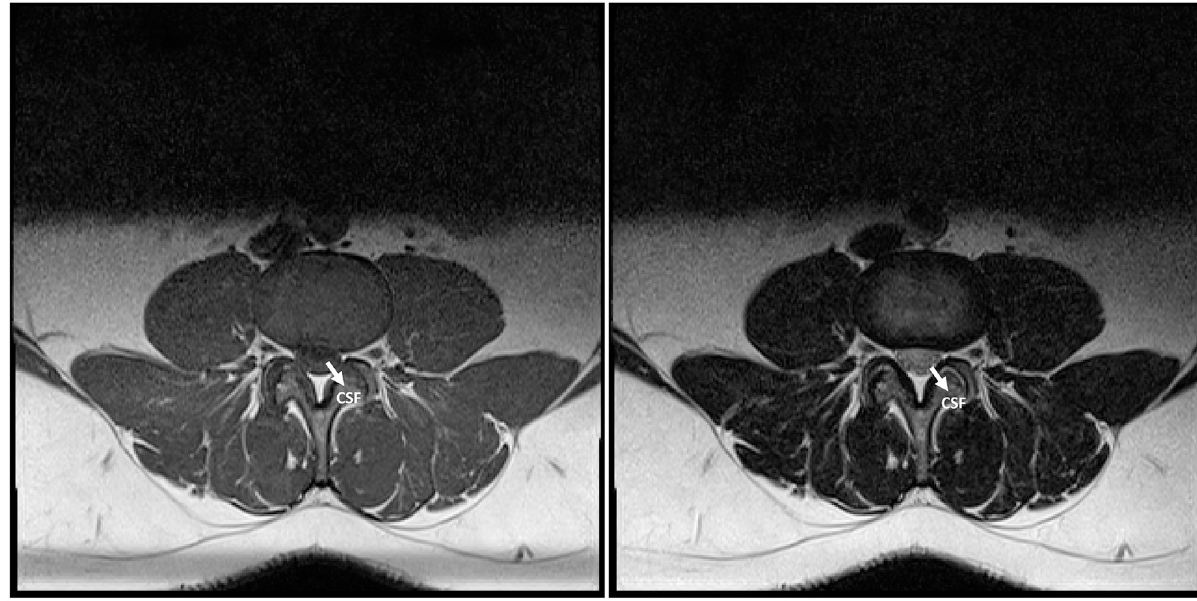
Fig 1. A T1-weighted (left) and a T2-weighted (right) traverse MRI images of the L3/L4 Intervertebral Disc of a patient are shown. One marked difference in the two images is the cerebrospinal fluid (CSF) in the spinal canal that appears black on the T1-weighted image but as a brighter region on the T2-weighted image because of its low fat